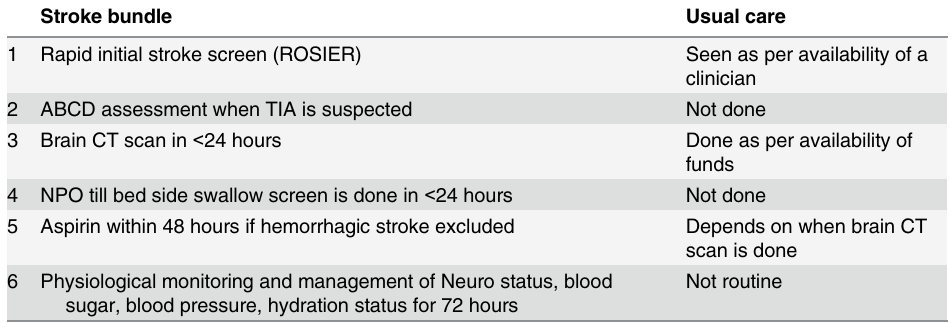
Table 1. Elements of the stroke care bundle versus ‘ usual care ’ for patients presenting to the Accident and Emergency unit with acute stroke. Stroke